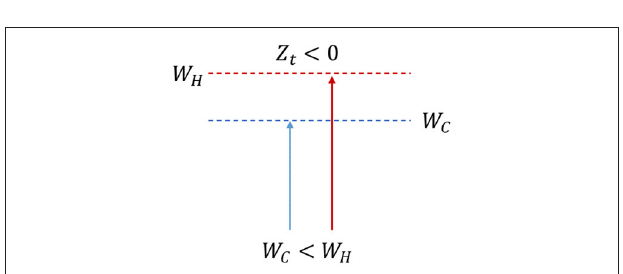
FIGURE 2 | The instinctual hot answer is triggered due to the too high cognitive costs to bear; the conditions to derive utility do not subsist.